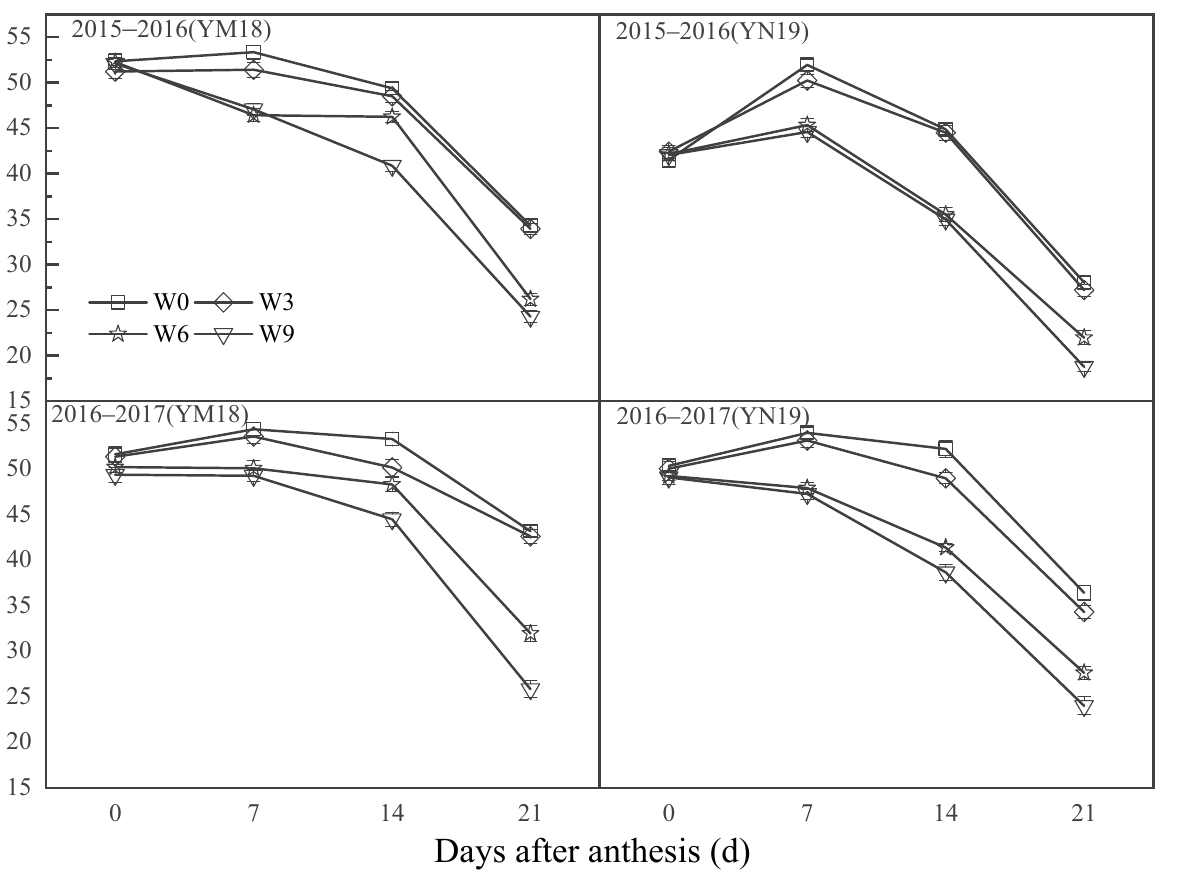
Figure 2. SPAD values of flag leaves under different treatments. Wheat genotypes YangMai18 (YM18) and YanNong19 (YN19) were subjected to soil waterlogging at anthesis for different durations and data were collected at 0, 7, 14 and 21 days after anthesis. W0 = control, W3 = 3 days of waterlogging, W6 = 6 days of waterlogging, W9 = 9 days of waterlogging. Each data point represents the mean ± SE of three independent replicates.